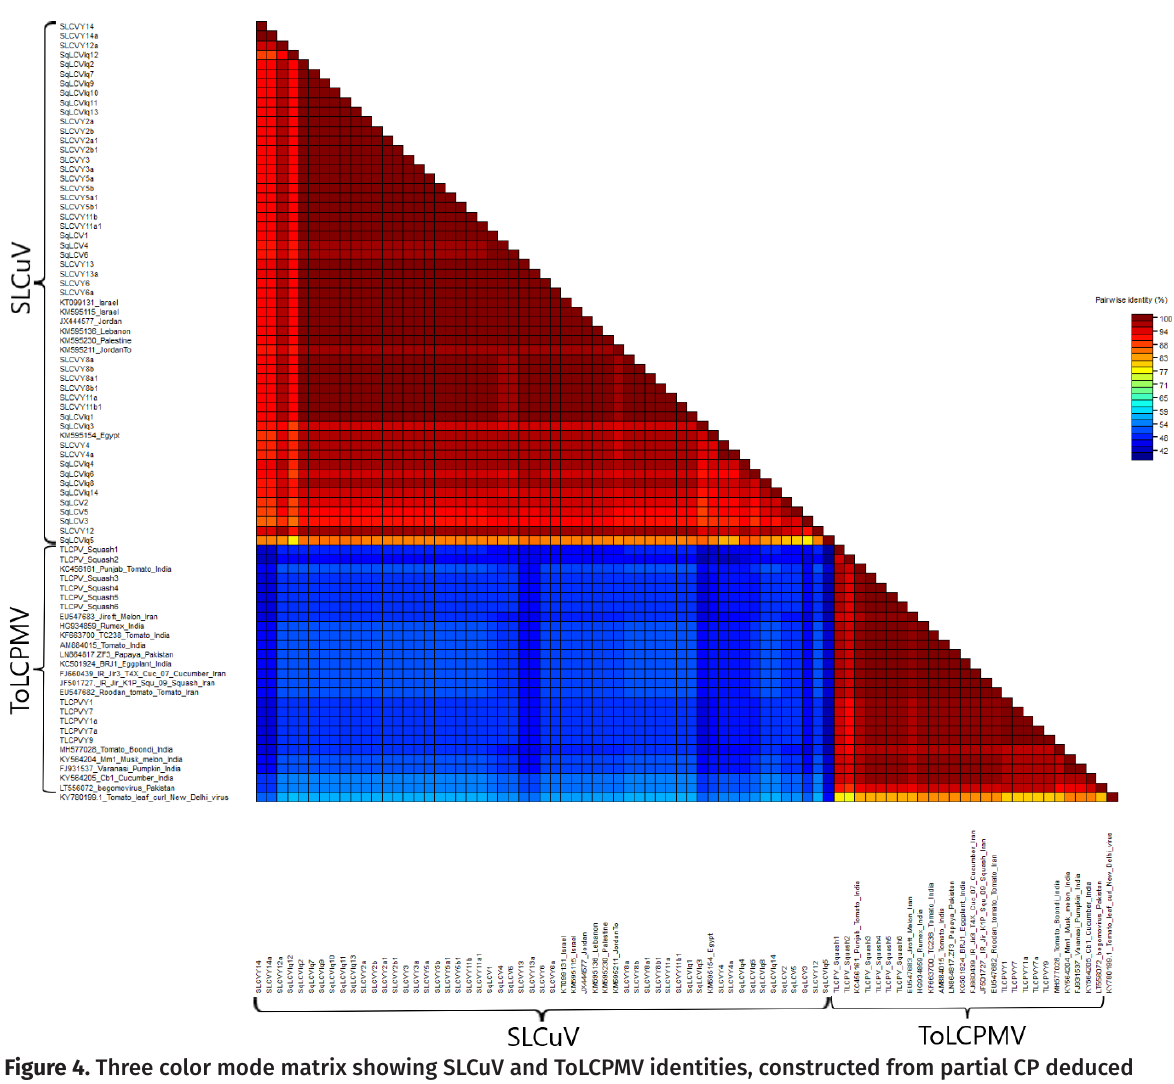
Figure 4. Three color mode matrix showing SLCuV and ToLCPMV identities, constructed from partial CP deduced amino acid sequences of isolated and the equivalent sequences from the GenBank. Tomato leaf curl New Delhi virus TLCNDV was used as an out-group